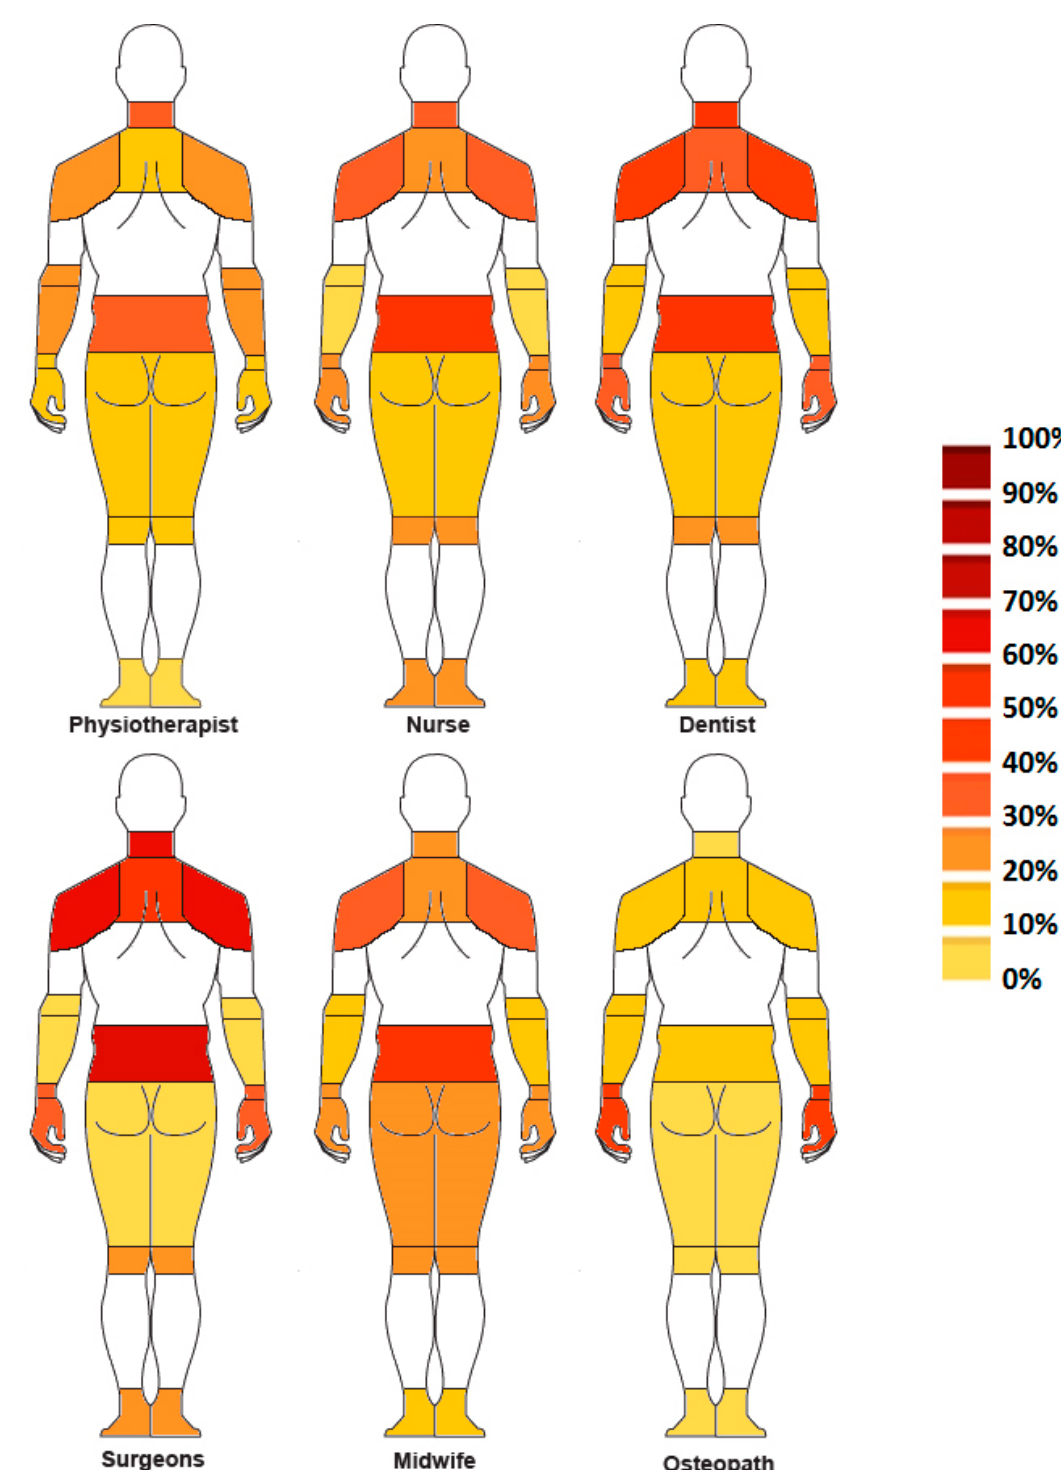
Figure 3. Body mapping of MSD prevalence by body areas and by healthcare profession. PT = Physiotherapists/Physical therapists.